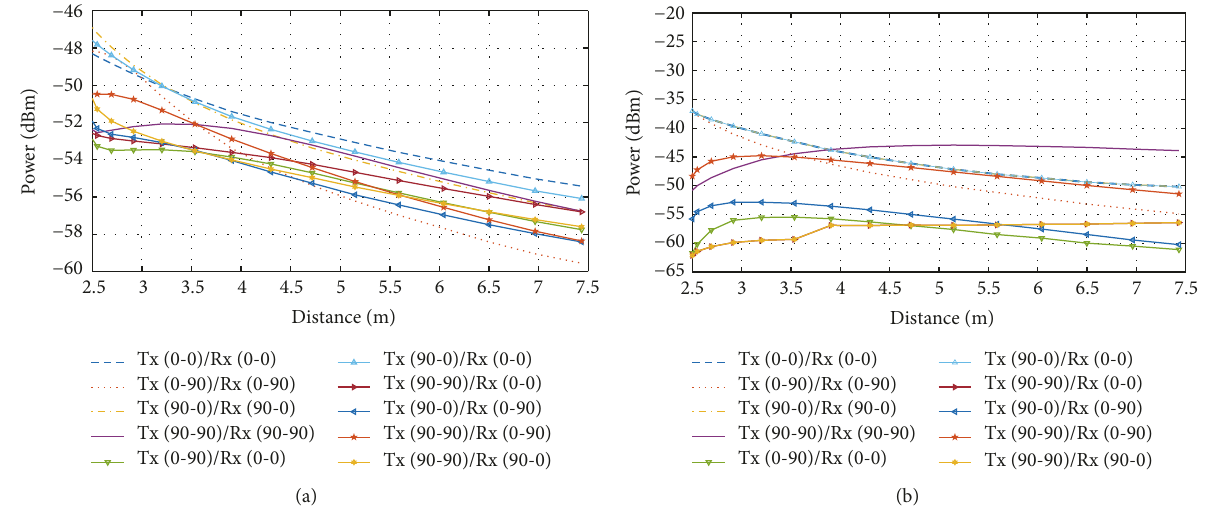
Figure 12: 𝑃𝑟 levels for both antennas in the NLOS scenario: (a) 3D cubic antenna and (b) dipole antenna.